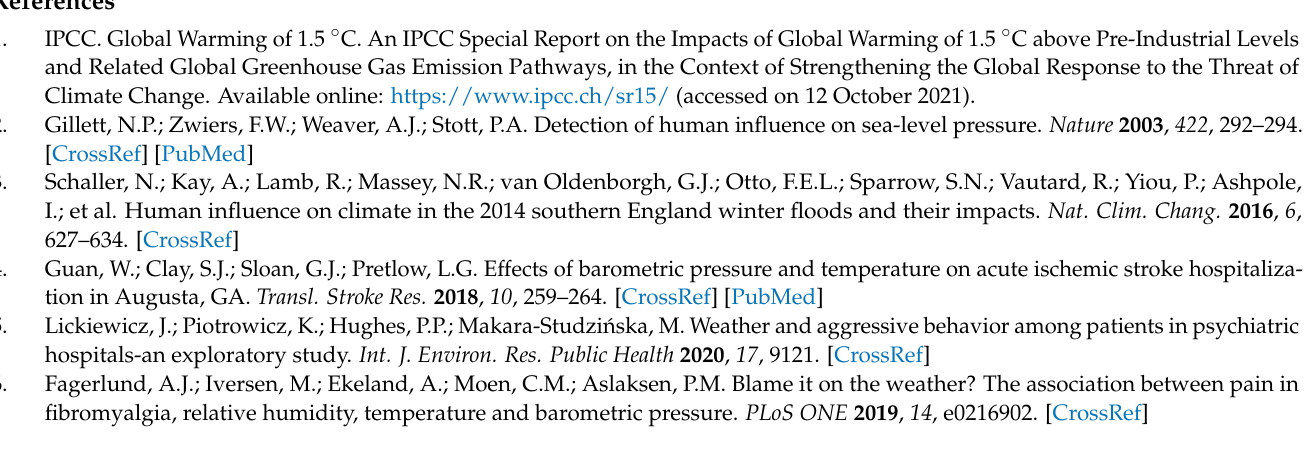
Figure S2: The fertility of D. melanogaster wild type strain Bi90 in comparison with variations of barometric pressure in Novosibirsk, Russia, in the end of July of 2020. Table S1. Principal component analysis (PCA) on meteorological data and fertility levels of Bi90 and 153 D. melanogaster strains. Table S2. Principal component analysis (PCA) on meteorological data and fertility level of Bi90 D. melanogaster